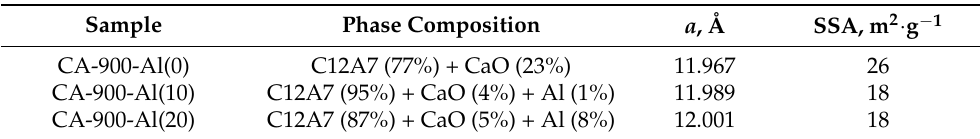
Figure 1. XRD patterns for the mayenite samples with varied content of aluminum additive after calcination in an Ar atmosphere at 900 °C. Table 1. Lattice parameter ( a ), phase composition, and specific surface area (SSA) of the mayenite samples calcined in an Ar atmosphere at 900 °C.